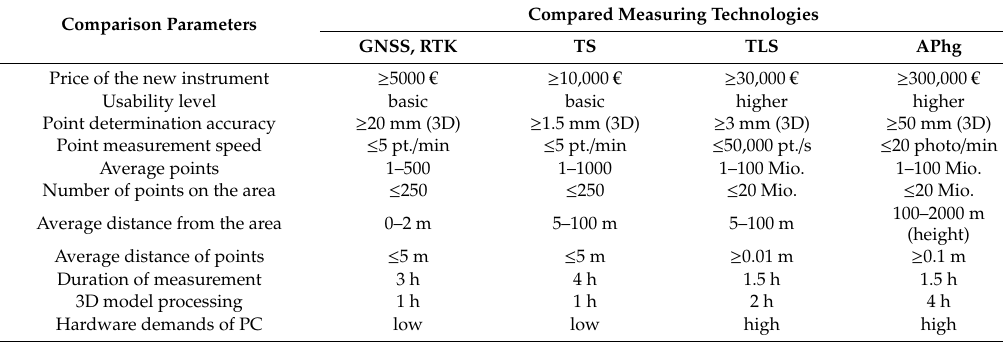
Table 2. Comparison of measuring technologies GNSS, TS, TLS,